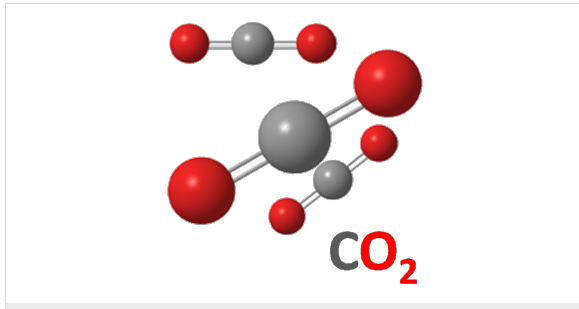
Figure 1: The carbon dioxide